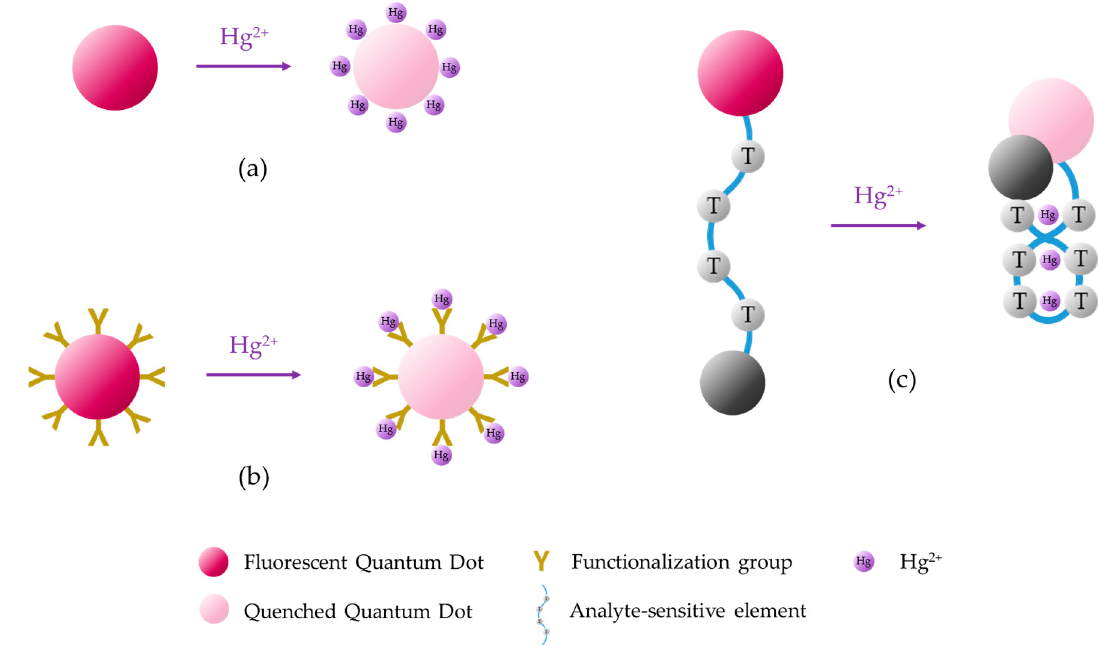
Figure 7. Sensing mechanisms based on fluorescent quantum dots: ( a ) direct interaction between the analyte and the QDs, ( b ) interaction of the analyte with the functionalized QDs, and ( c ) integration of the QD with another sensory material.